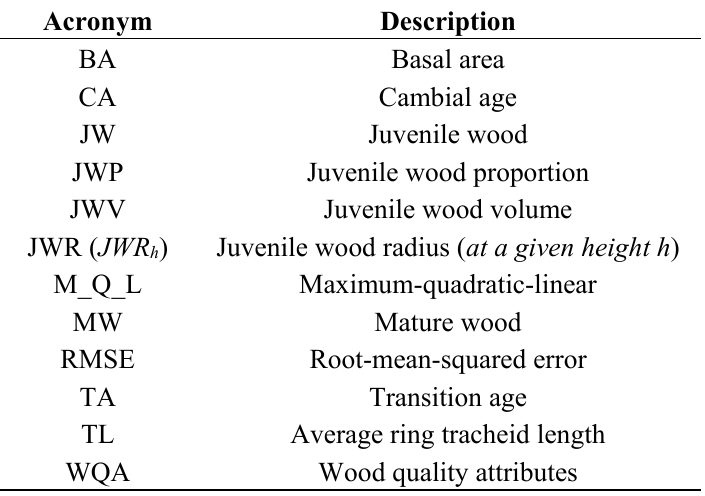
Table 1. Acronyms used in the text and their